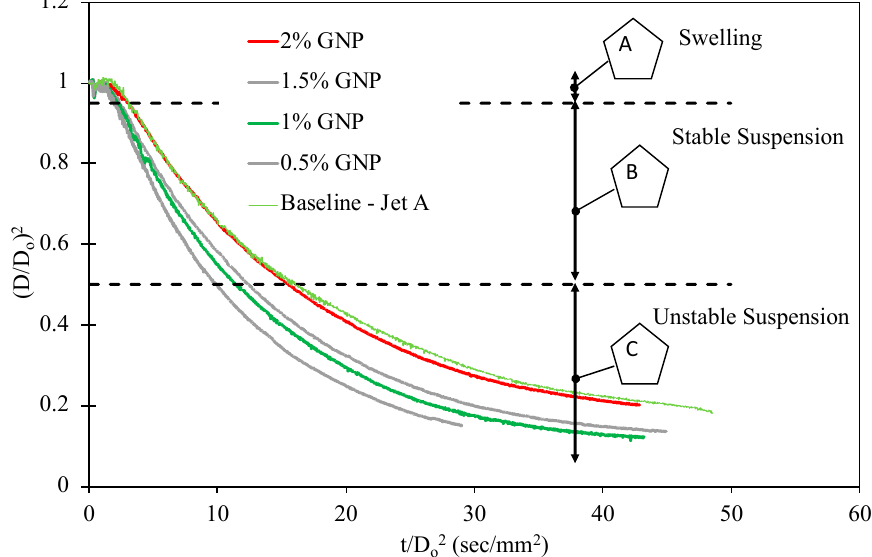
Figure 4. Evolution of diameter square for colloidal suspensions of jet fuel + GNP. The dashed lines represent the bounds of the steady evaporation zone.